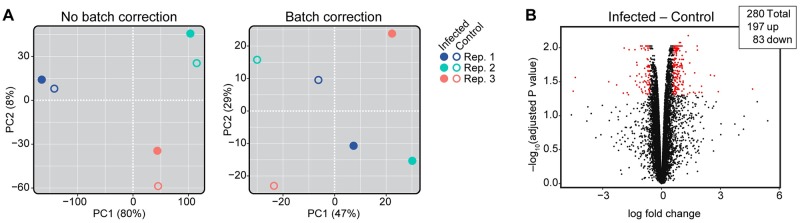
Differentially regulated genes in C. fasciculata-infected Ae. aegypti hindguts.(A) PCA analysis shows that before batch correction (left) the most significant source of variation is experimental replicate (Rep; different colors). Applying batch correction (right) separates control, uninfected (open circles) from infected samples (solid circles) along PC1, which now accounts for 47% of the variation between samples. (B) Volcano plot showing changes in gene expression in infected hindguts compared to uninfected hindguts. A positive value indicates an Ae. aegypti transcript that is upregulated in infected hindguts. Red dots indicate transcripts that are significantly differentially expressed. Numbers of differentially expressed genes with a log2 fold change of at least 0.59 and adjusted P value < 0.05 are shown in the inset.